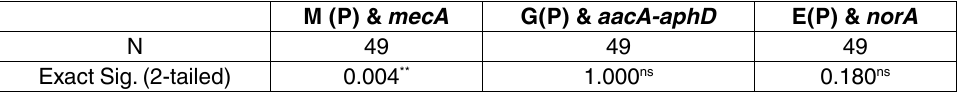
table 2. Comparison of phenotypic and genotypic characterisation of antimicrobial resistance in